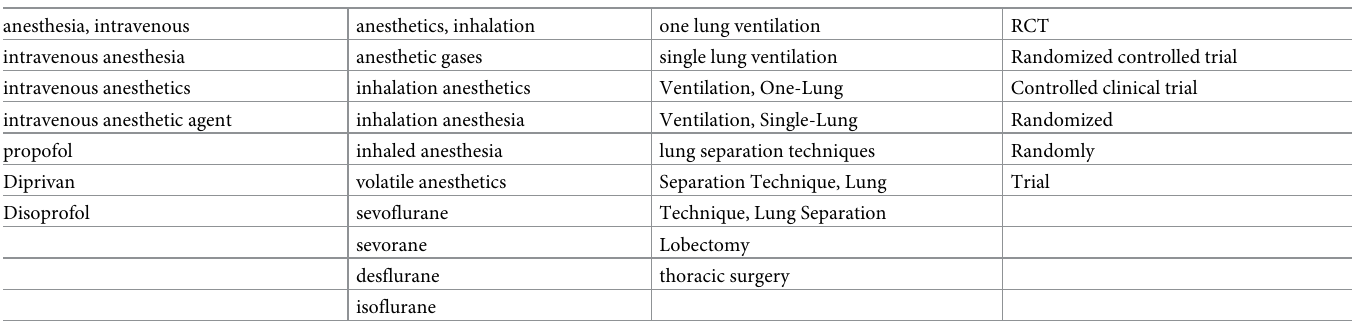
Table 1. The specific keywords and MeSH terms during the screening